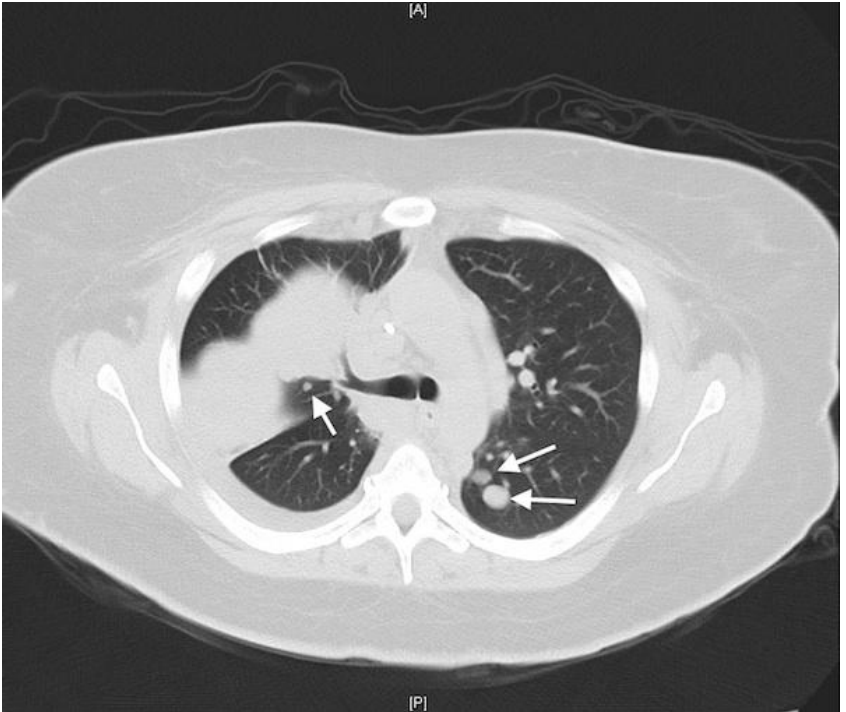
FIGURE 2. Computed tomogram of the chest demonstrating multiple pulmonary nodules thought to be metastases from the sarcoma